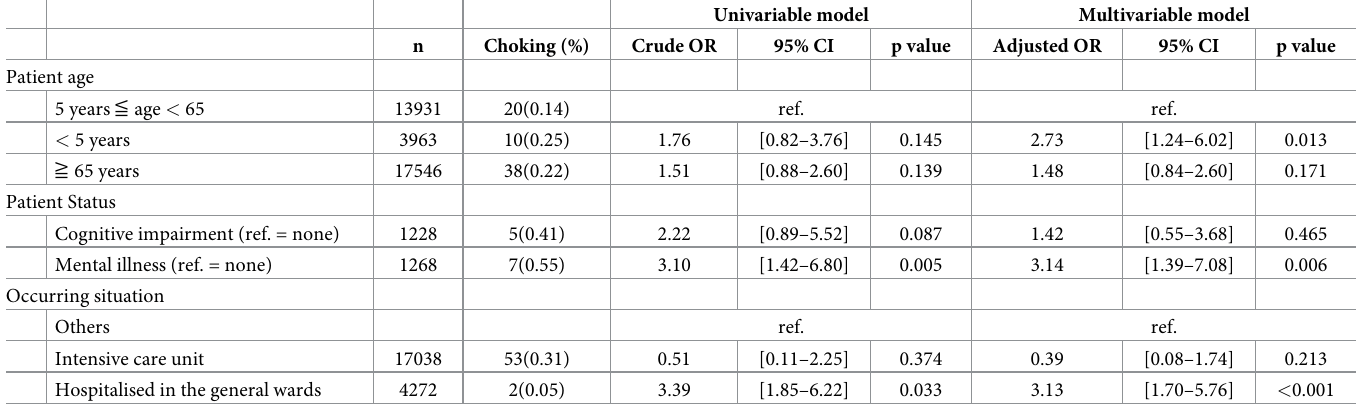
Table 2. Contributory factors for choking in logistic regression